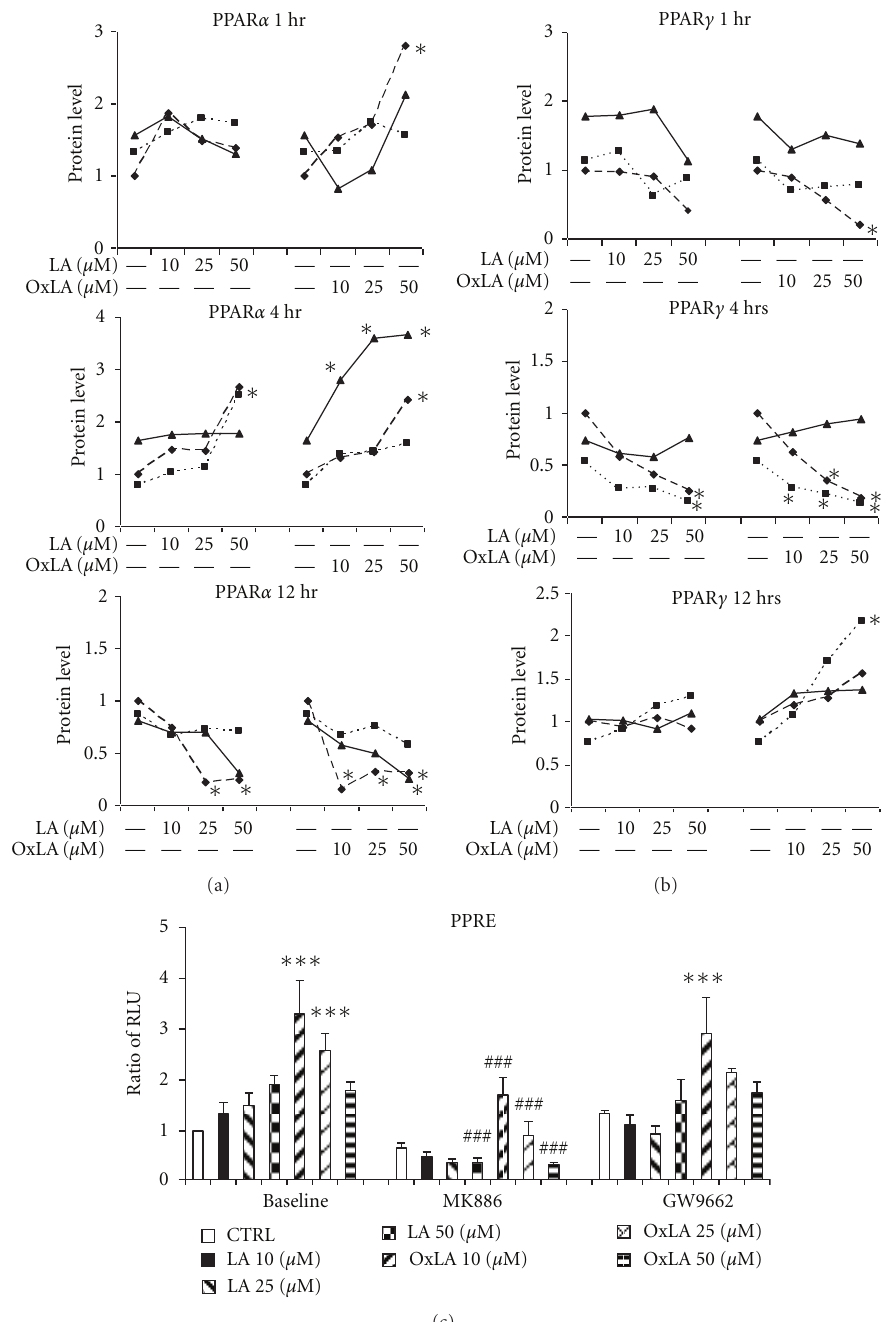
Figure 1: ω -6 lipids modulate PPAR protein levels and PPRE transactivity in a time-dependent manner. Western blotting of RASMC lysates treated with 10–50 μ M of LA and OxLA for 0–12 hrs using PPAR α and PPAR γ antibody shows induction of PPAR α at acute phase and PPAR γ at subacute phase. Control (CTRL) was defined as the cells treated with vehicle only. The results were expressed as mean ± SEM (Standard Error of Mean) defined by the ratio of protein levels in treated samples compared to CTRL. All data were normalized to β -actin (house- keeping protein) (a) PPAR α protein levels after 1hr, 4hr, 12hrs treatment. (b) PPAR γ protein levels after 1hr, 4 hr, 12hrs treatment. The figure is a representation of three independent blots. One way ANOVA was used for the comparison between two treatments. Significance was confirmed using post hoc analysis using Fisher LSD test. ∗ P < 0 . 05. (c) PPAR transactivity was measured in PPRE-luciferase transfected RASMCs which were pretreated with 10 μ M MK886 (PPAR α antagonist) or 1 μ M GW9662 (PPAR γ antagonist) followed by exposure to 10–50 μ M LA or OxLA for 4hrs. The assay were run in duplicates and repeated three independent times. The results were expressed as mean relative luciferase activity ± SEM (Standard Error of Mean). One way ANOVA was used for the comparison between two treatments. Significance was confirmed using post hoc analysis using Fisher LSD test. ∗ compared to CTRL, P < 0 . 05; # compared to 10 μ M concentration, P < 0 .